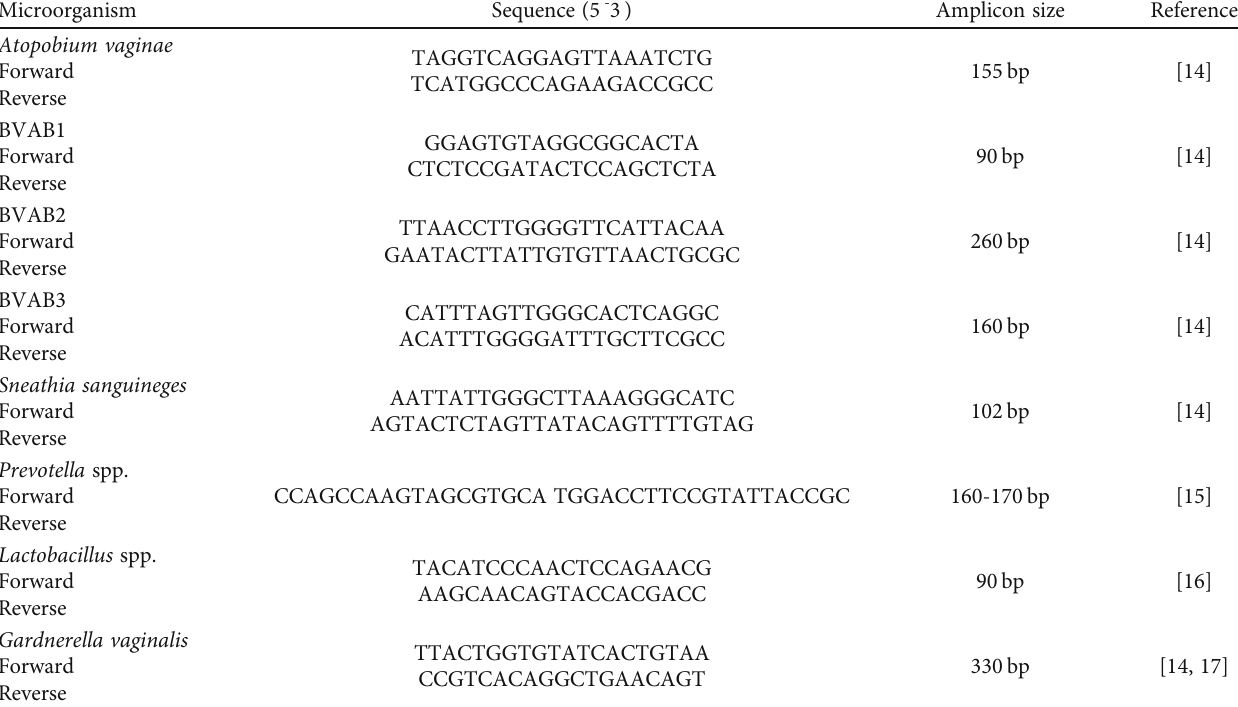
Table 1: Primer sequences for real time PCR of cervico-vaginal